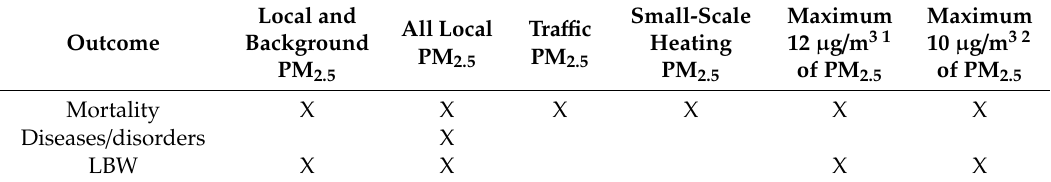
Table 1. Air pollution scenarios analyzed: Removal of various PM 2.5 sources and the removal of PM 2.5 concentrations exceeding the United States EPA and WHO air quality